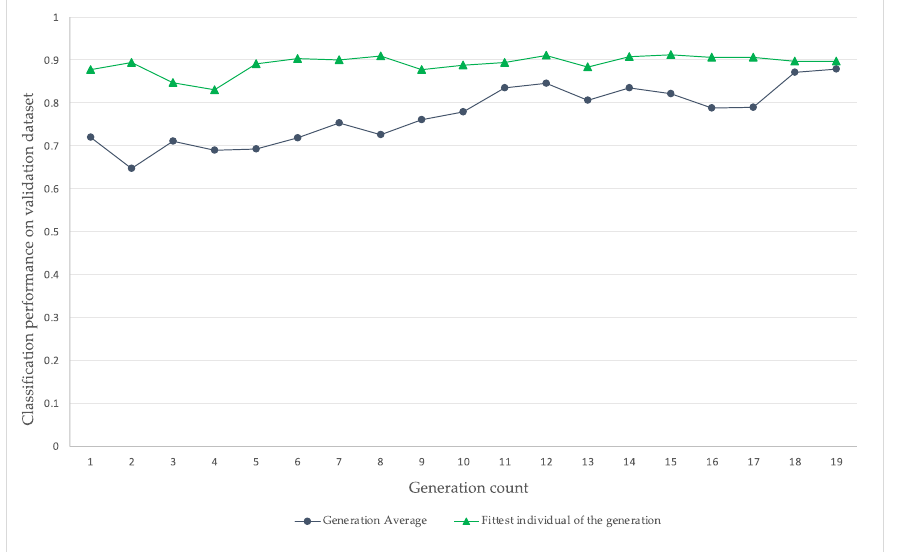
Figure 6. Average and top validation performances of CNNs on for all populations during the evo- lutionary optimisation.